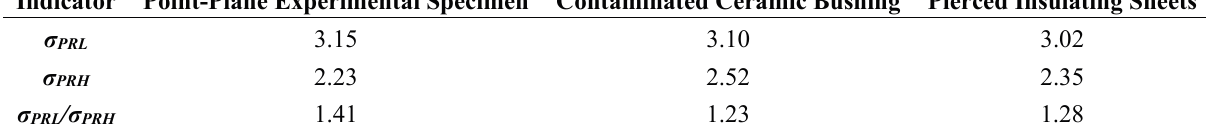
Table 2. Results obtained of the standard deviation for each cluster associated with electrical